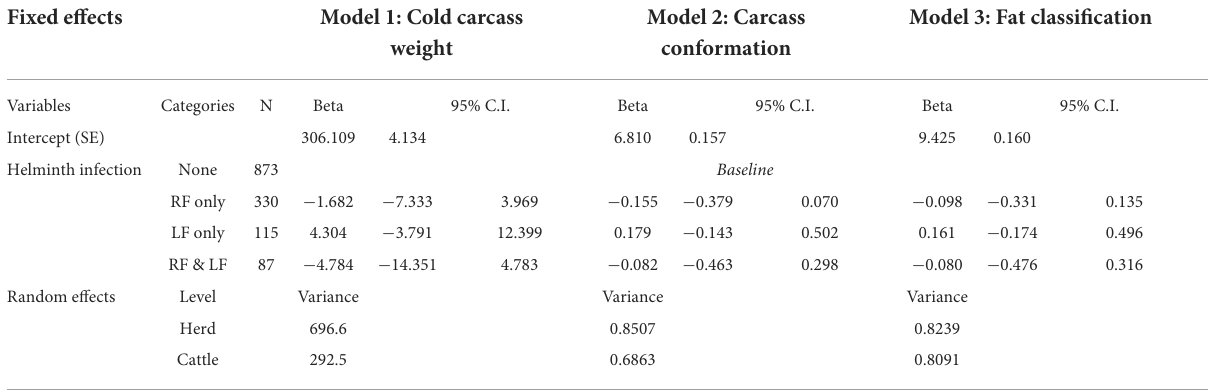
TABLE 3 Effect of rumen fluke infection on three measures of carcass quality.